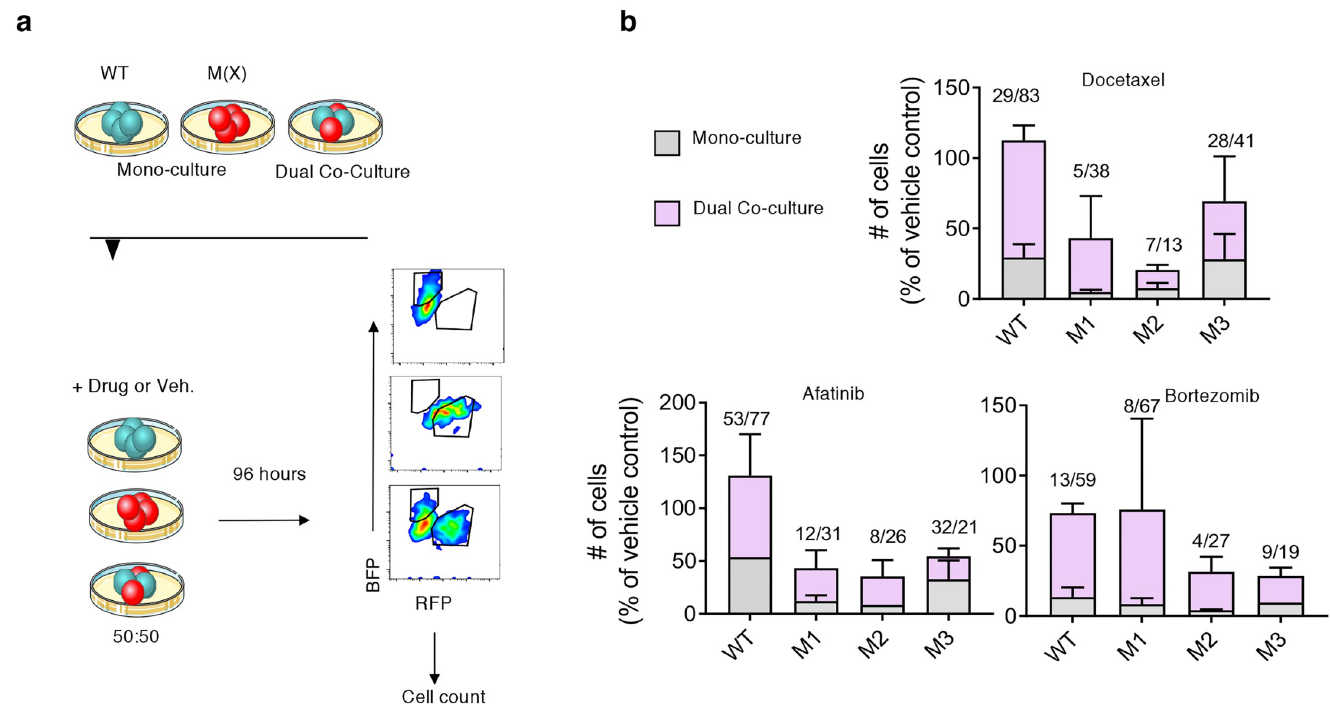
Fig 2. In vitro tumor spheroid growth of wild-type and Dicer1 mutant NSCLC clones. a) Experimental design schematic. Fluorescently-tagged WT or mutant NSCLC clones (M1, M2 or M3), designated as M(X), were cultured alone or in a heterotypic 3-D co-culture (WT+M) at 50:50. Drugs or vehicle control were introduced to culture for 96 hours followed by flow cytometry and count of gated cells (see Methods for details). b) Stacked histograms quantify the number of cells in each clone remaining in spheroids after 96 hours drug treatment in mono-culture or mixed, dual co-culture with WT. WT stacked bar graph indicates mono-culture or co-culture with mutants. Values above columns indicate the % mean in monoculture/co-culture. Experiments performed in biological replicate on independent occasions (N > 3 in each group). Error bars indicate standard error from the mean.